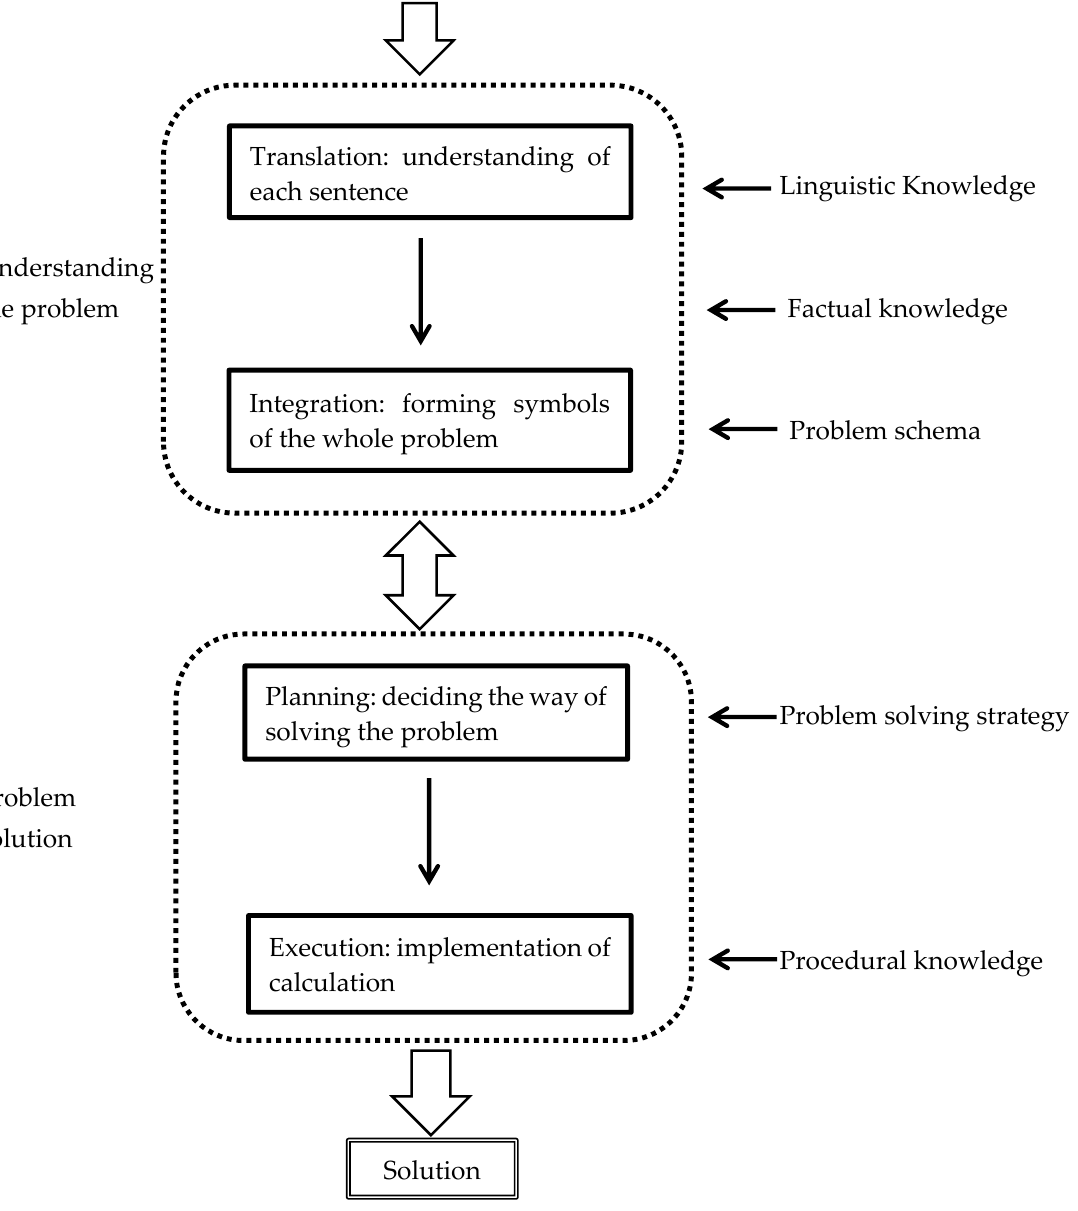
Figure 1. Four levels of procedures of mathematical problem solving. (Source: Seo 2010, p. 230 translated by Yoshitaka Nakakoji).